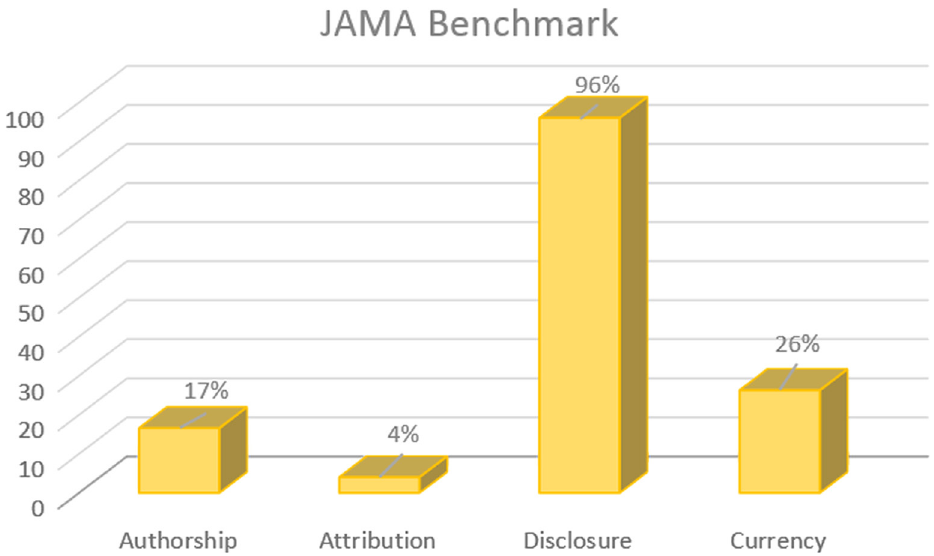
Figure 4. JAMA benchmark scores of all analysed